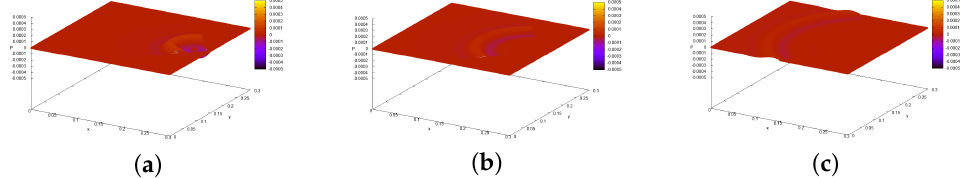
Figure 5. Test 2. Inverse problem 2. Additional information (function p ( x , y , t ) ). ( a )—pressure distribution at t = 0.06 ms, ( b )—pressure distribution at t = 0.11 ms, ( c )—pressure distribution at t = 0.16 ms .